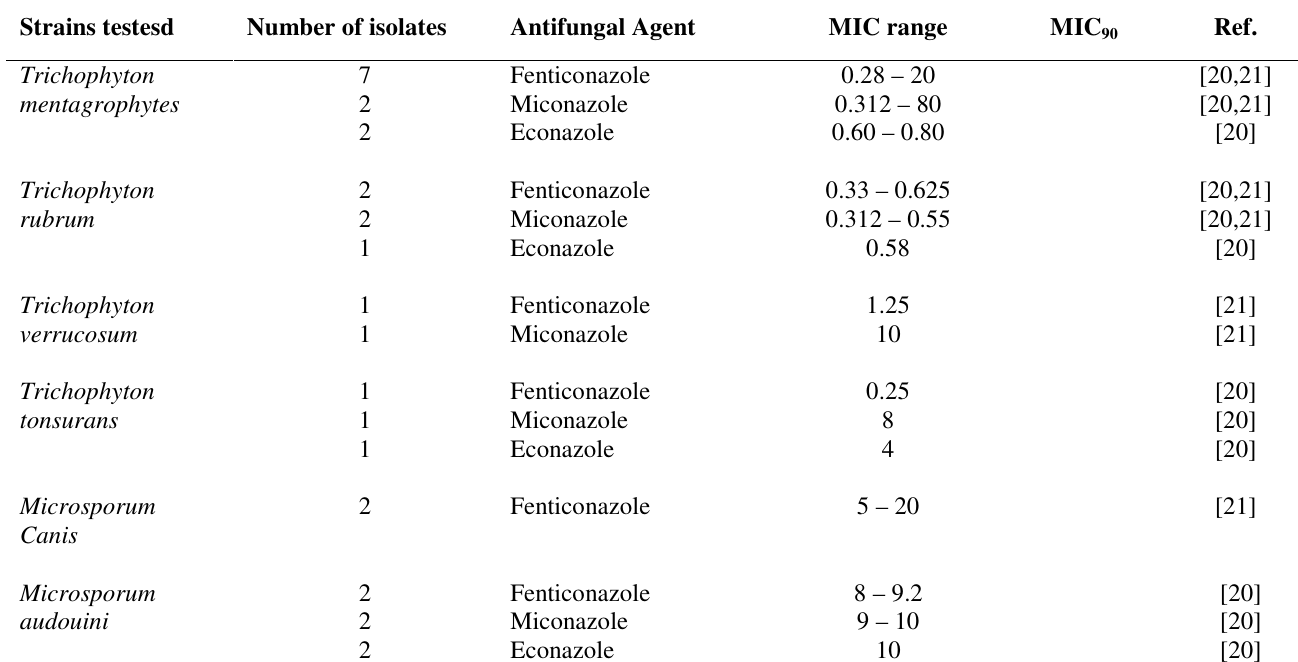
7. MIC’s ( µ g/mL) of sertaconazole, fluconazole, miconazole, econazole, isoconazole, sulconazole, butoconazole, ketoconazole, fenticonazole, and itraconazole against clinical isolates of different fungal